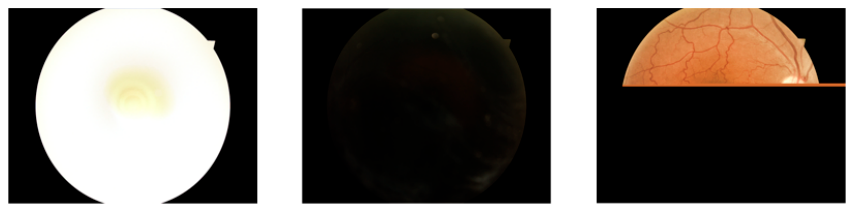
Figure 1. Examples of unusable fundus image data (the images are from the EyePaCS dataset [36]).